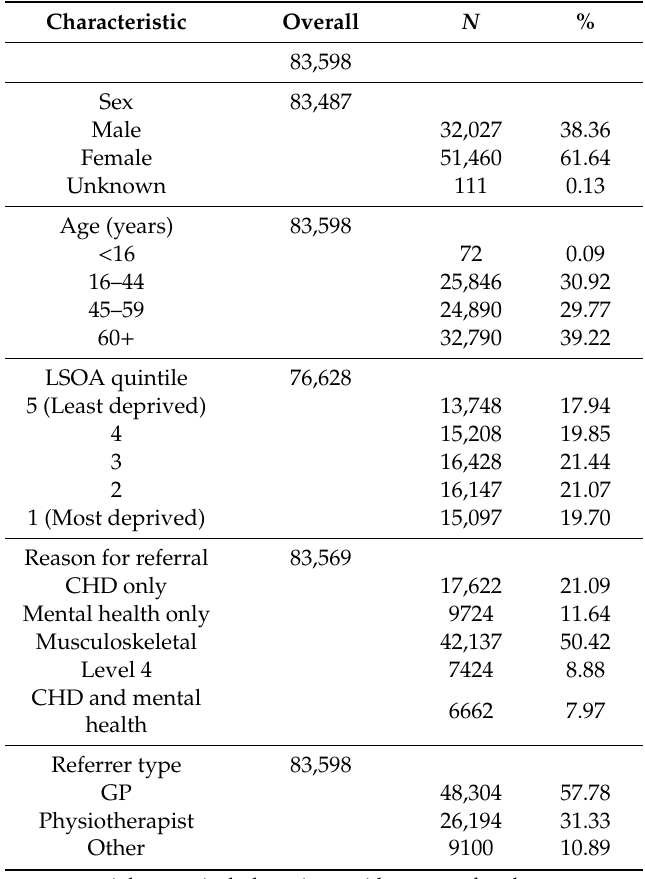
Table 1. Characteristics of all National Exercise Referral Scheme (NERS) referrals between 2008 and 2017